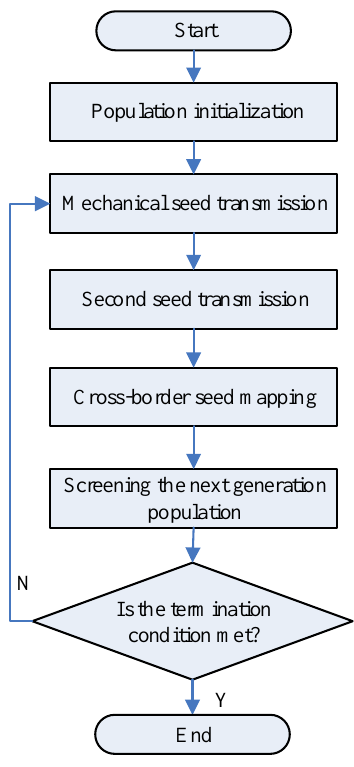
Figure 1. Framework of GBO algorithm.